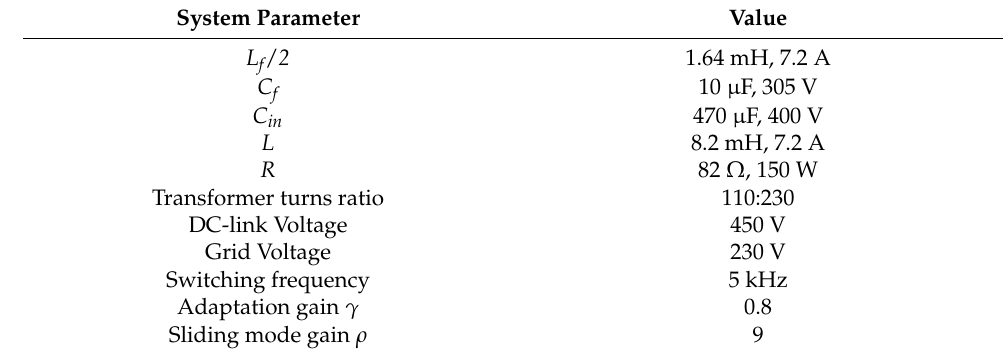
Table 1. Simulation parameter.